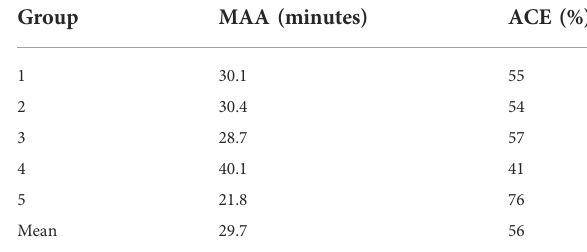
TABLE 5 MAA and ACE numerical